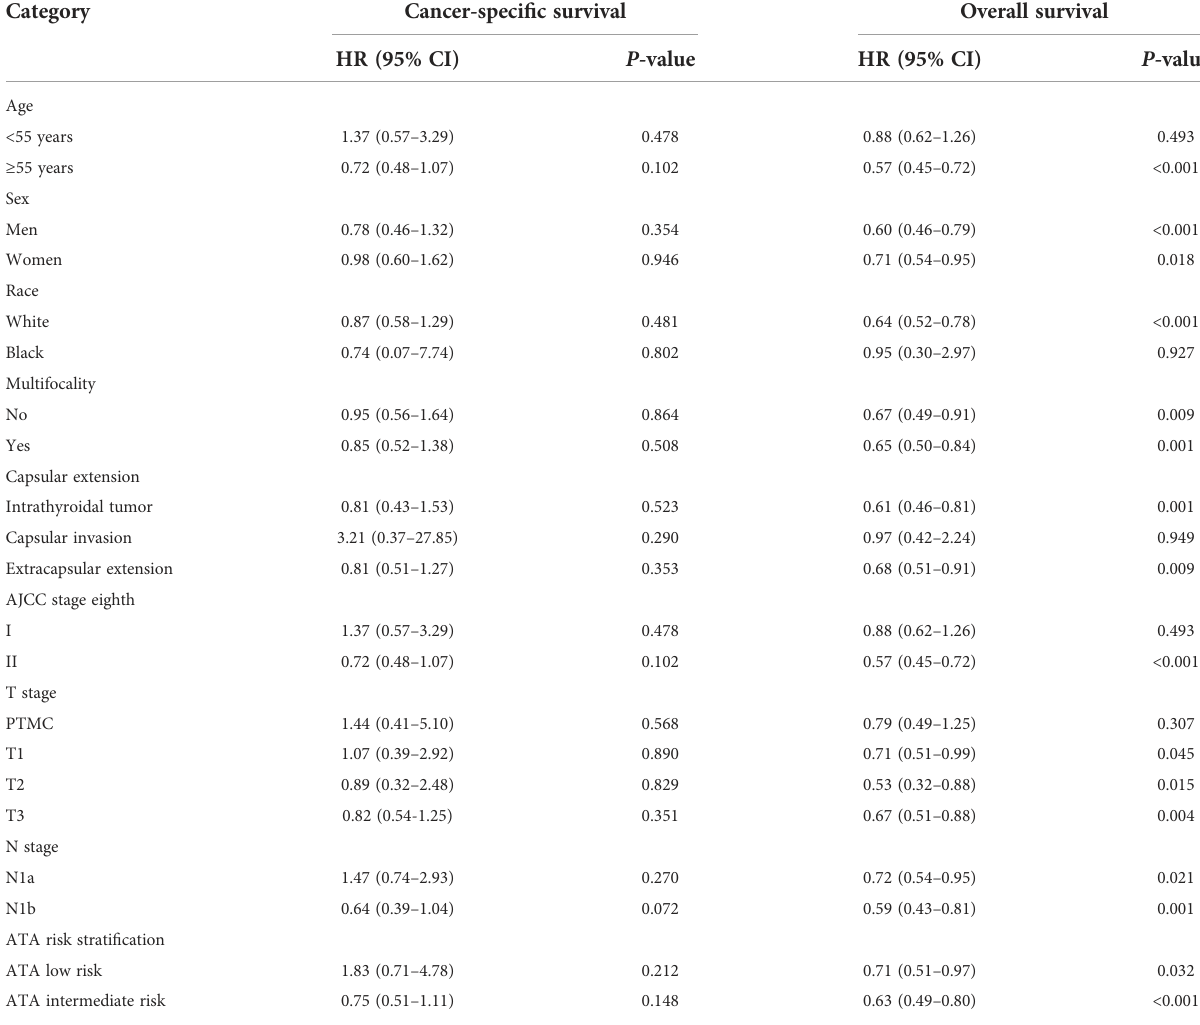
TABLE 3 Subgroup analysis for cancer-speci fi c survival and overall survival of TT with RAI vs. TT alone by multivariate Cox regression analysis.